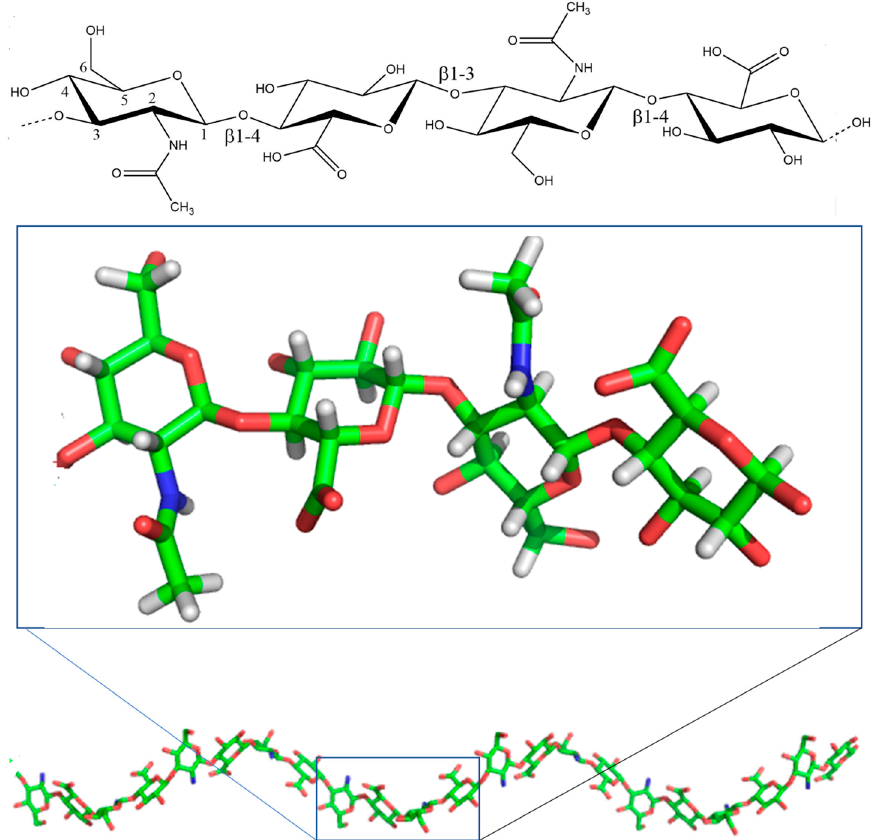
Figure 1. Chemical structure of two repeating units of HA; ( β -D-GlcNAc 1 → 3 β -D-GlcA 1 → 4)n; 3-D representations of the low energy conformation of a tetrasaccharide unit, extracted from a longer segment shown in an extended two-fold helical conformation.